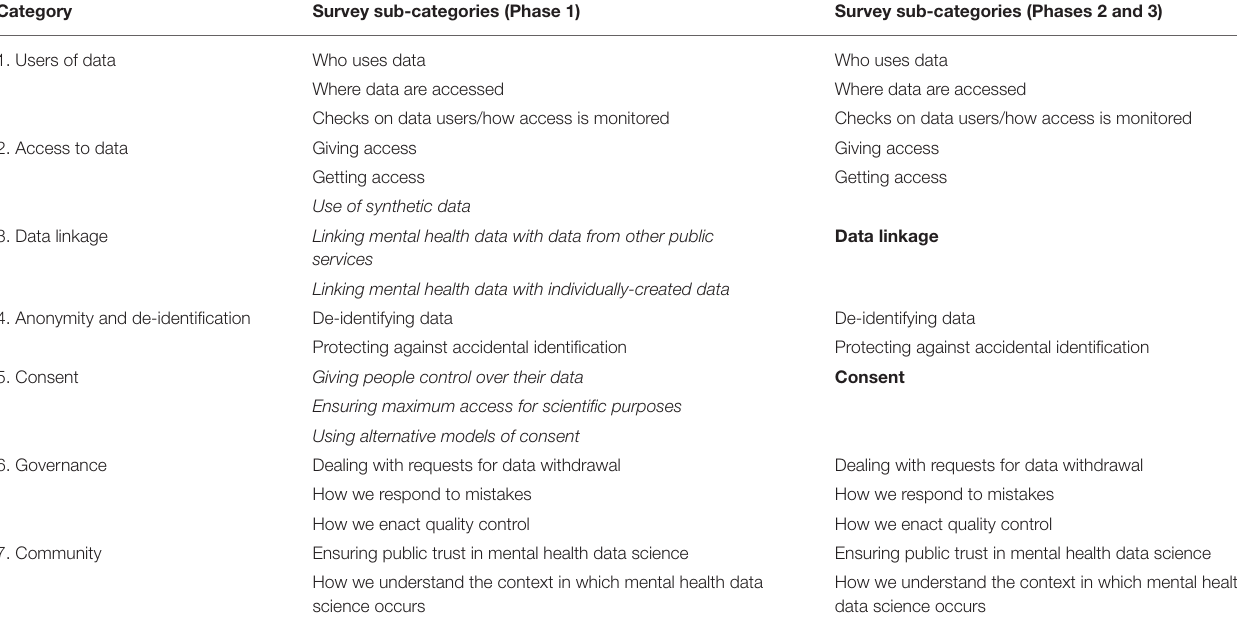
TABLE 3 | Categories and sub-categories for statements and items included in the surveys.